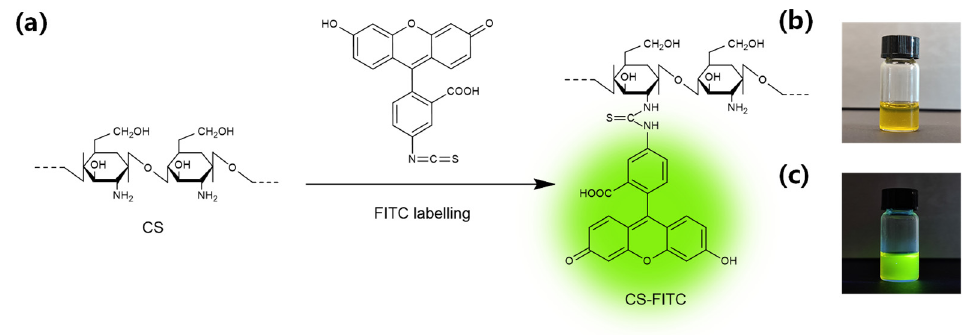
Figure 1. ( a ) Schematic reaction of CS and FITC for the formation of CS-FITC; ( b ) CS-FITC solution in natural light; ( c ) CS-FITC solution under excitation.